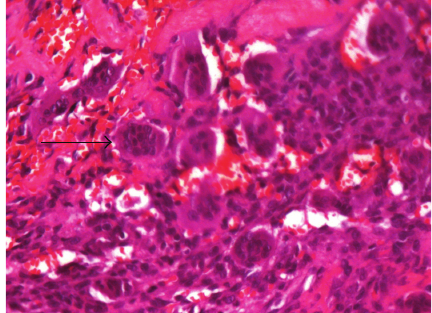
Figure 1: Hematoxylin and eosin-stained tumor tissue depicting osteoclast-like giant